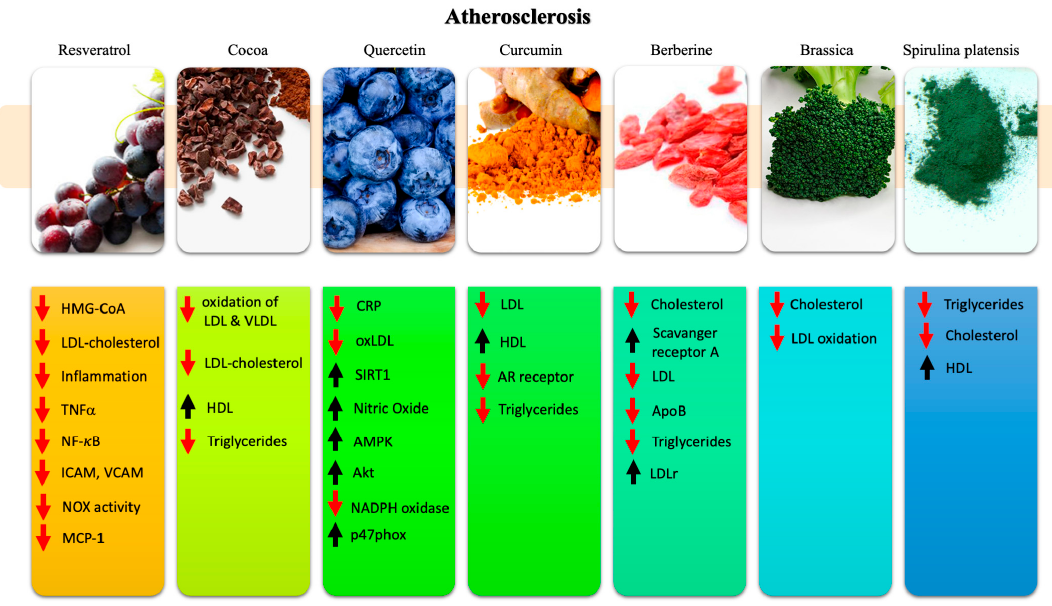
Figure 2. Summary of the main molecular and physiological e ff ects exerted by resveratrol, cocoa, quercetin, curcumin, brassica, berberine, and Spirulina platensis in the atherosclerotic process. Red arrow ( ↓ ) indicates downregulation; black arrow ( ↑ ) indicates upregulation.